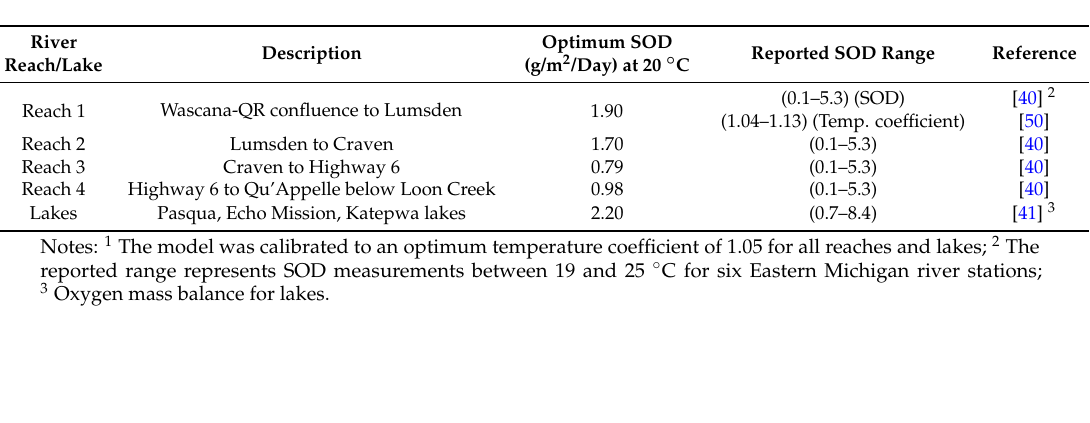
Table 2. Calculated Model Segment SOD rates and temperature correction coefficient 1